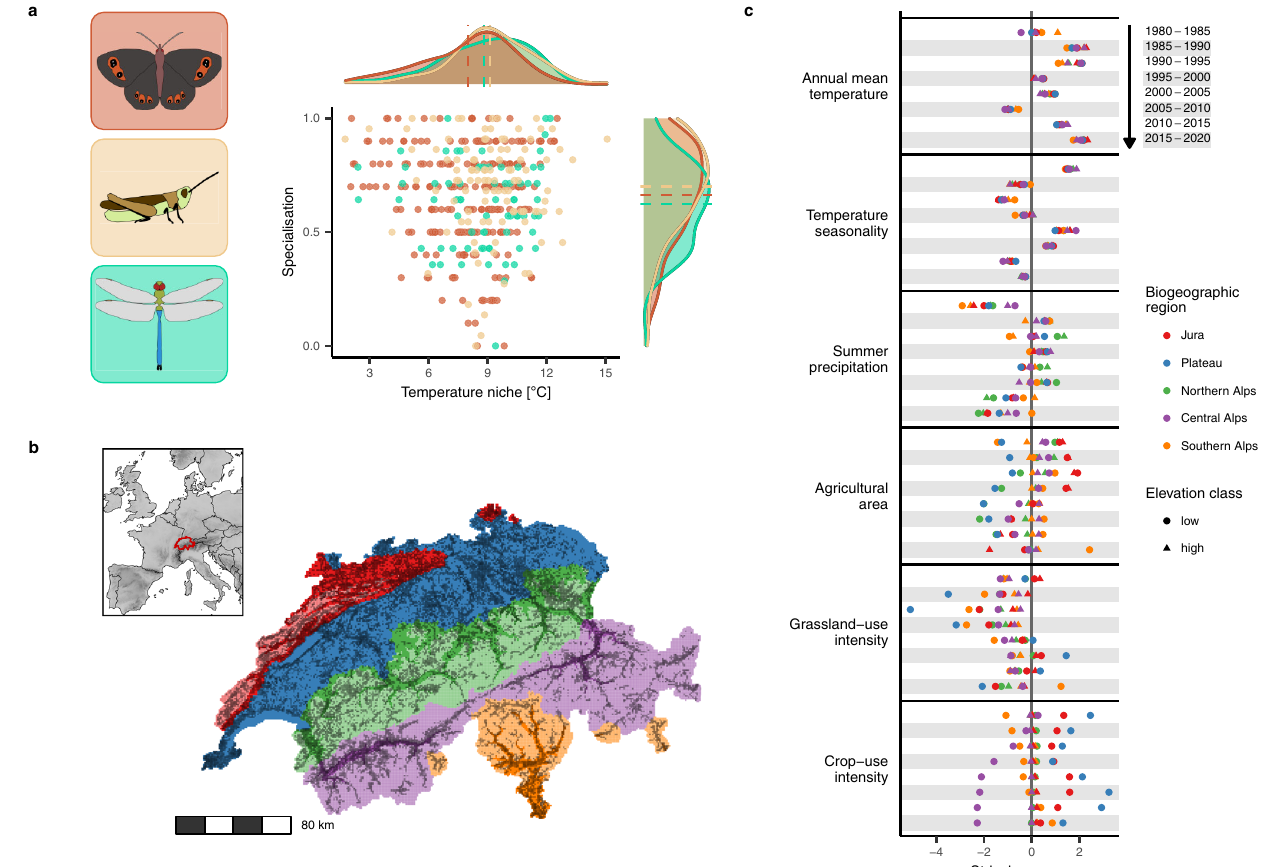
Fig.1|Studyspecies,studyregion,andclimateandland-usechanges.a Intotal, 215 butter fl y species, 103 grasshopper species and 72 dragon fl y species were analysed, which covered a gradient in habitat specialisation (0: lowest specialisa- tion;1:highestspecialisation;basedonliterature-derivedhabitatpreferences)and in preferred temperature niches (average annual temperatures of Europe-wide distribution). Curves show marginal density distributions per group and trait; dashed lines indicate means. b Switzerland, the study country situated along the Alps in Central Europe, was divided into fi ve biogeographic regions indicated by colours (legend in ( c )) and two elevation classes (above and below 1000m asl.;